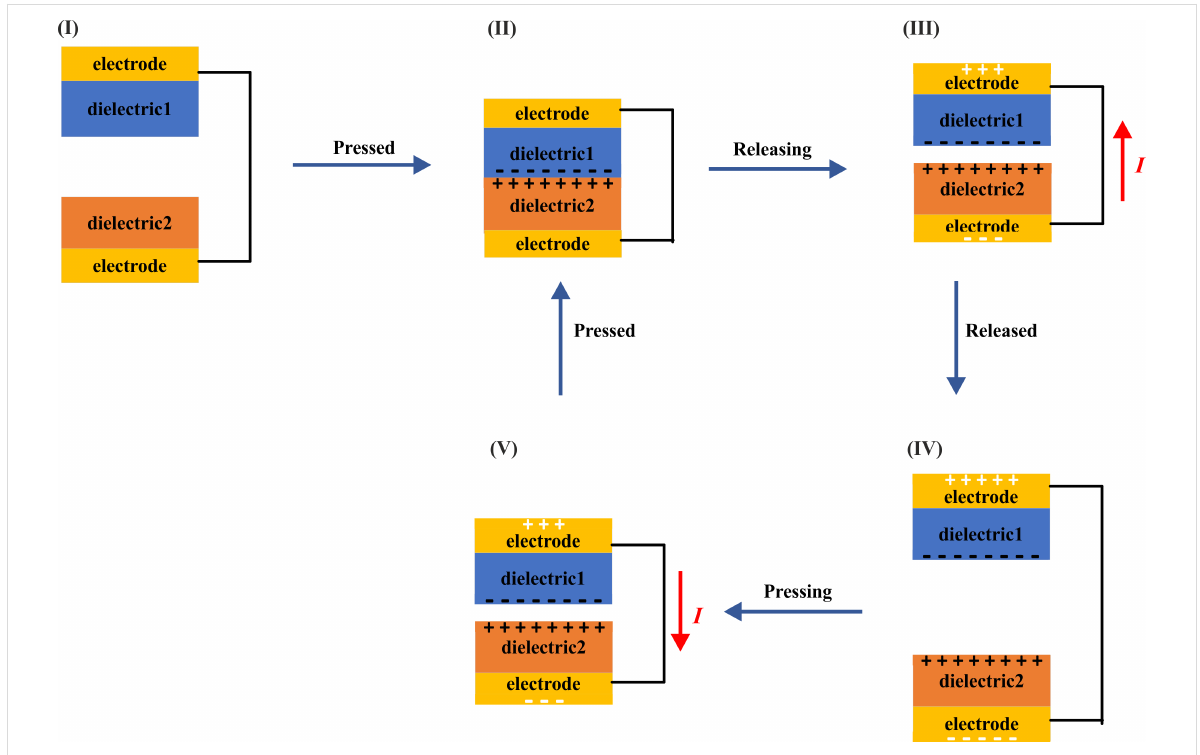
Figure 1: Charge flow in a triboelectric